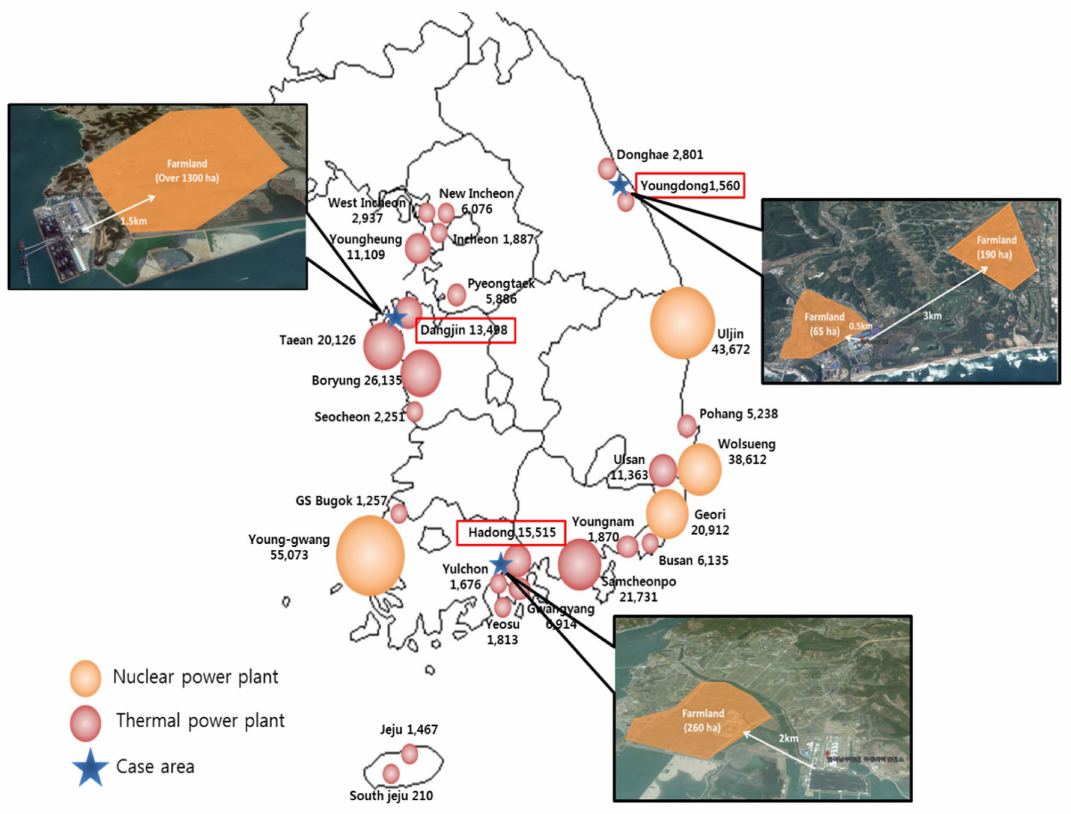
Figure 1. Case study areas with energy reserves